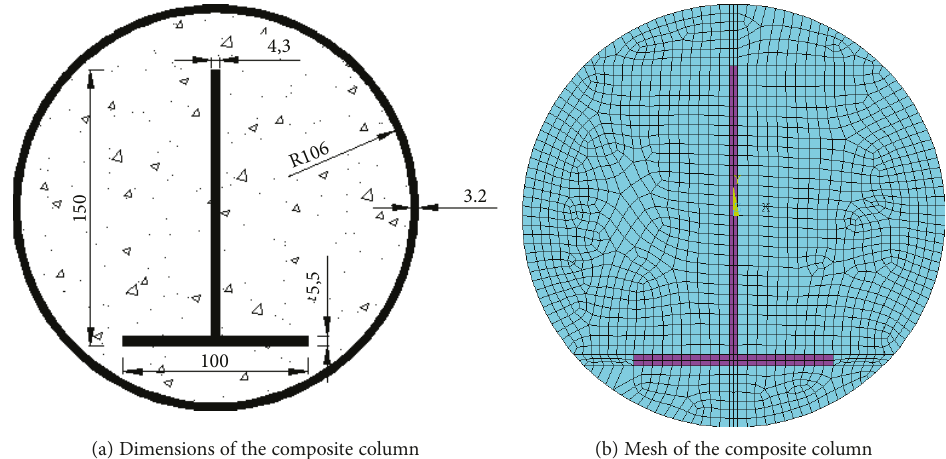
Figure 3: Dimensions and mesh of the prede fi ned column; e ff ect of stress-strain models of con fi ned concrete.